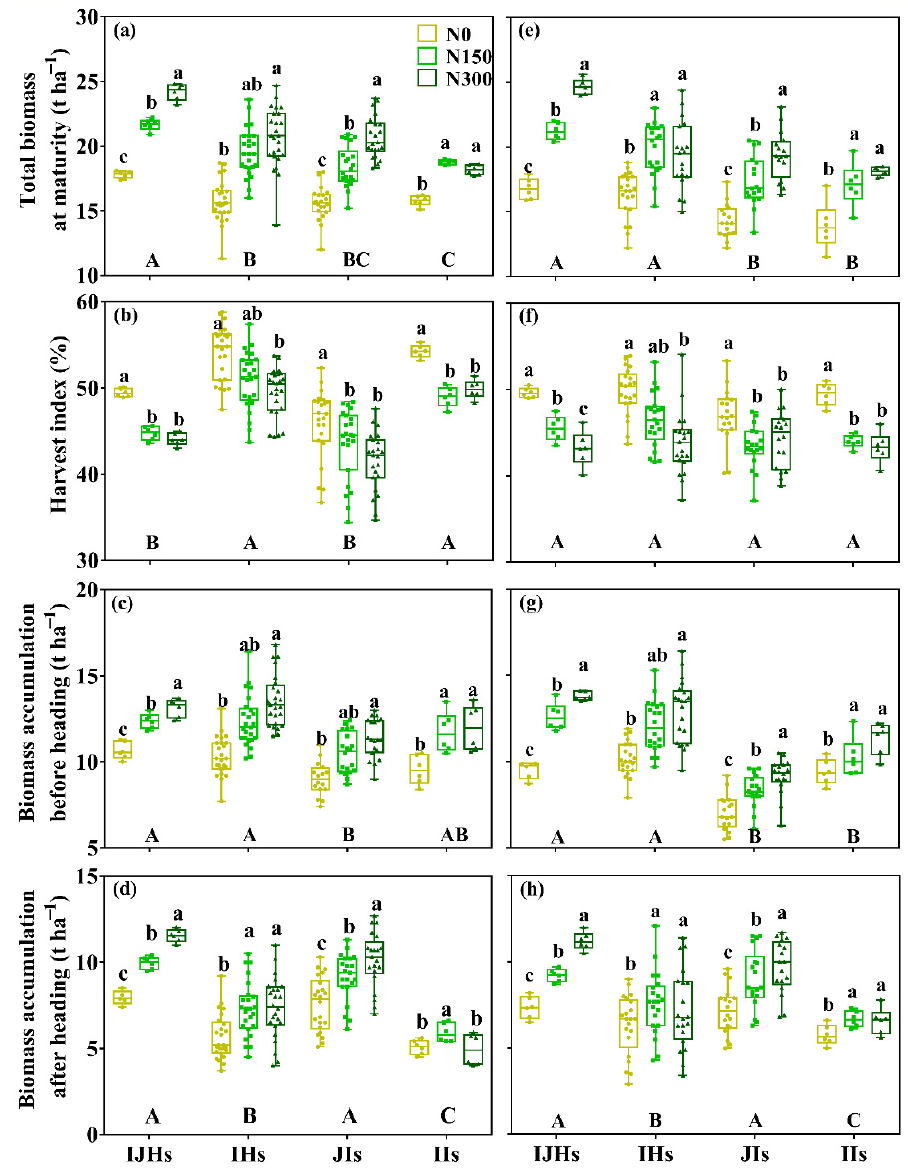
Figure 6. Boxplots of total biomass at maturity ( a , e ), harvest index ( b , f ), biomass accumulation before heading ( c , g ), and biomass accumulation after heading ( d , h ) for indica-japonica hybrids (IJHs), indica hybrids (IHs), japonica inbreds (JIs), and indica inbreds (IIs) under different N levels in 2017 ( a – d ) and 2018 ( e – h ), respectively. Data are the means of three replicates. Different uppercase letters above the columns indicate statistical significance at the p < 0.05 level among the different rice groups, and different lowercase letters above columns indicate statistical significance at the p < 0.05 level among different nitrogen levels.